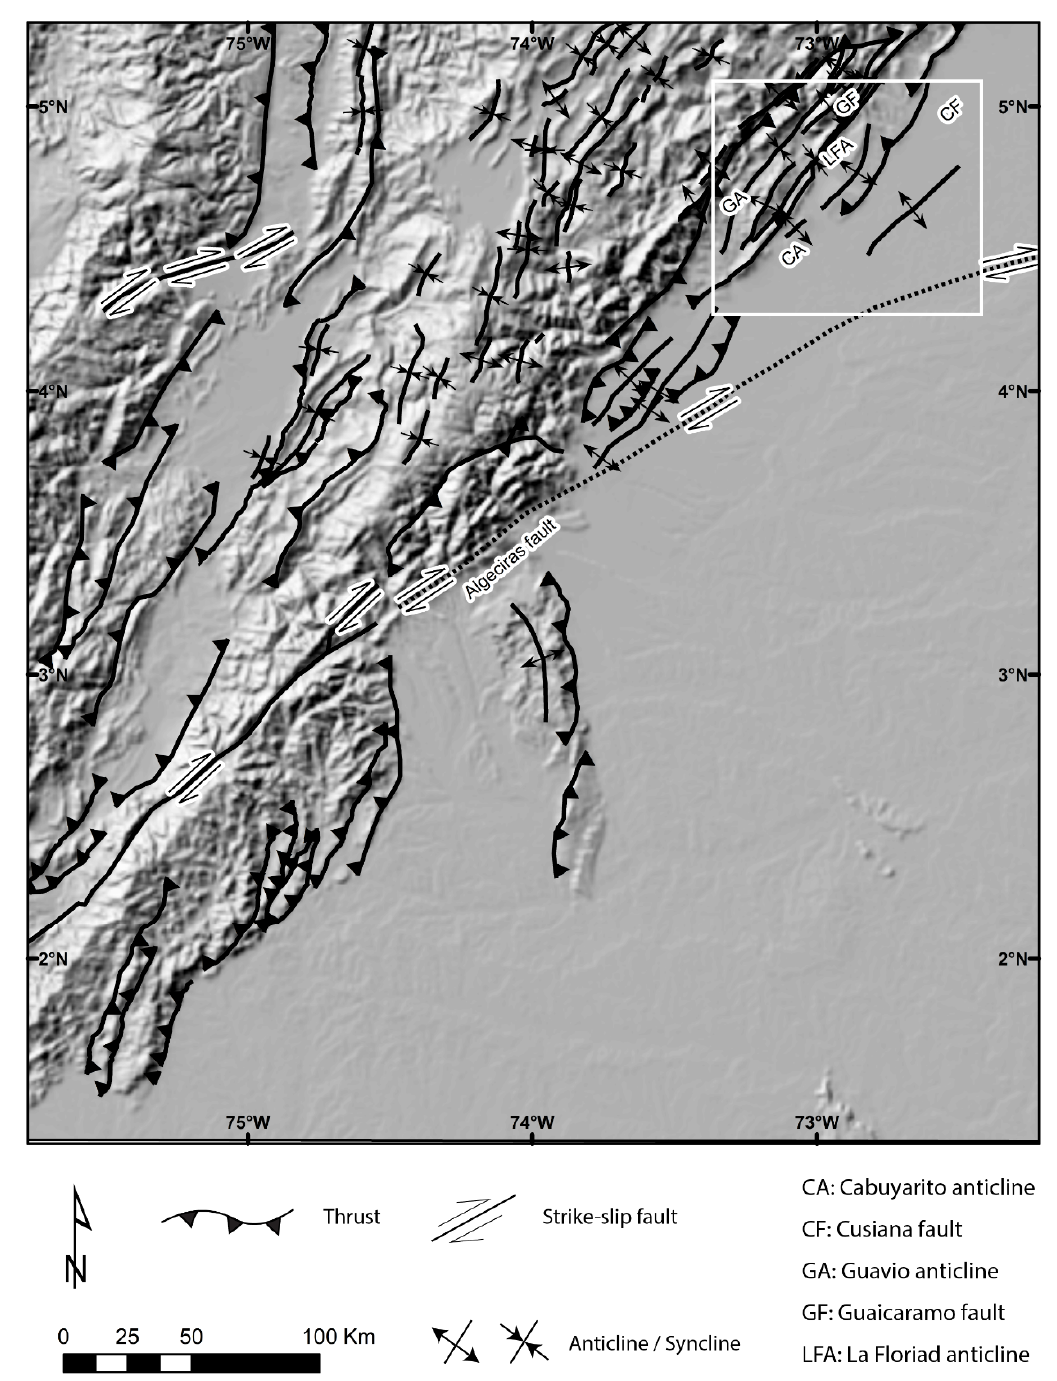
Figure 16. Topographic map with structural elements of the southeastern flank of the Eastern Cordillera and Llanos basin. Note the proximity of the Algeciras fault to the study area (white box, Figure